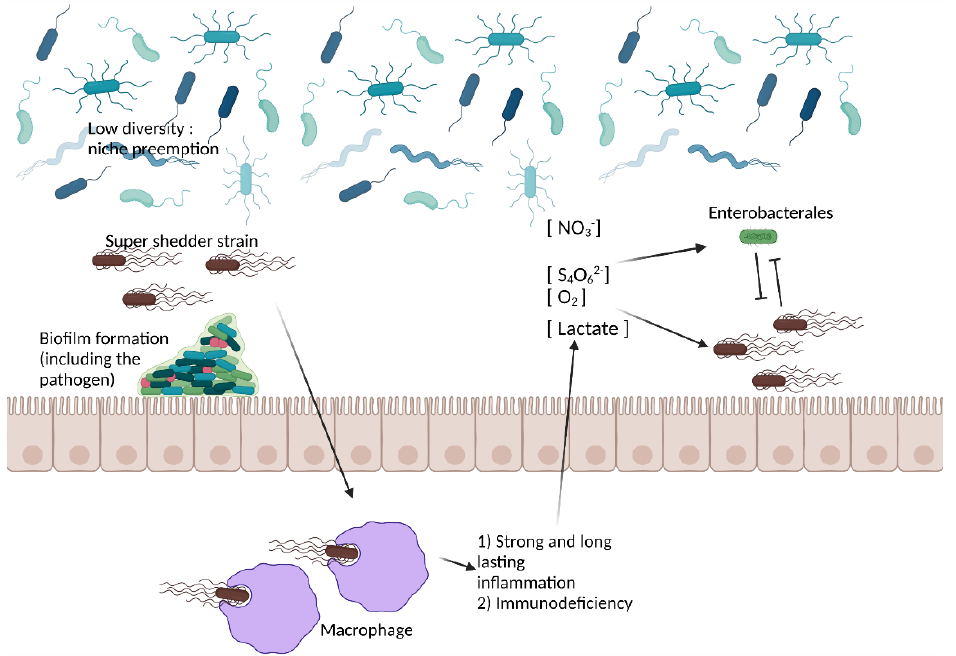
Figure 3. Possible mechanisms at play in the super shedder phenotype. A gut presenting with low diversity exhibits low microbiota-nourishing immunity and may be more prone colonization by the pathogen. Virulence factors may induce a strong inflammatory response, thus creating a new niche for pathogen installation, altering its metabolism. Then, the pathogen faces competition from other closely related bacteria (e.g., Enterobacterales in the case of Salmonella and E. coli O157:H7), thanks to specific bacterial compounds, which may lead to its luminal expansion. Alternatively, immuno- deficiency may lead to luminal expansion of the pathogen. Created with BioRender.com, accessed on 18 October 2022.